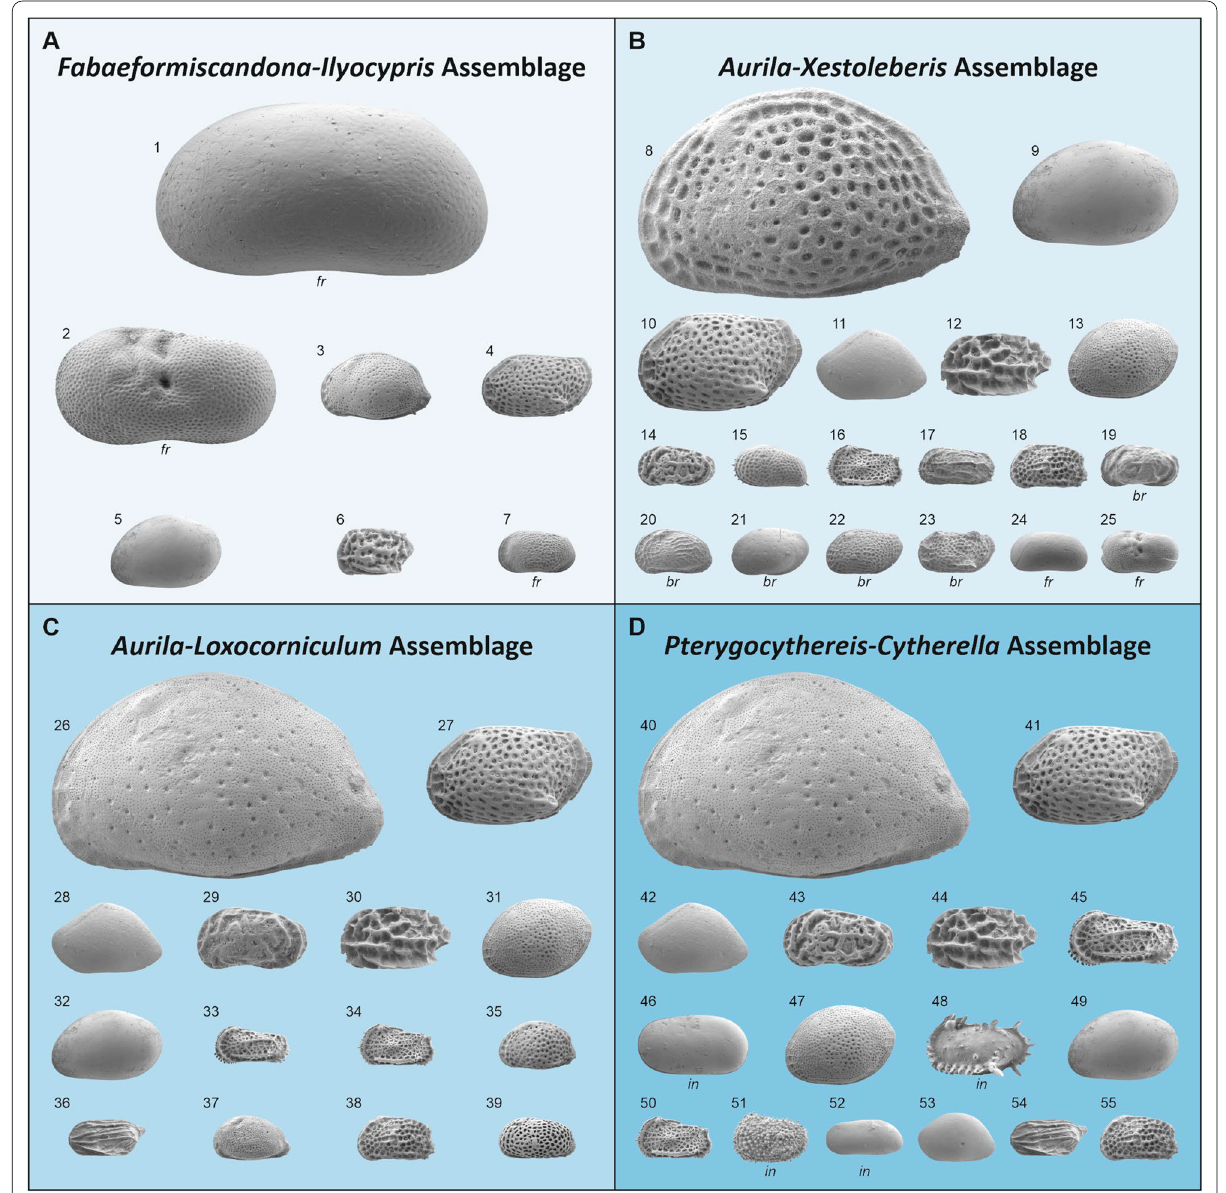
Fig. 13 Schematic illustration of ostracod assemblages (not to scale). A Fabaeformiscandona - Ilyocypris assemblage, B Aurila - Xestoleberis assemblage, C Aurila - Loxocorniculum assemblage, D Pterygocythereis - Cytherella assemblage. Size of figured valves refer to their frequency in the assemblage. Paleoecologically significant taxa marked with fr (freshwater), br (brackish water or epineritic with freshwater influx) and in (infraneritic to (epi-)bathyal). 1: Fabaeformiscandona sp. 1; 2: Ilyocypris aff. gibba ; 3: Aurila cicatricosa ; 4: Loxocorniculum hastatum ; 5: Xestoleberis tumida ;